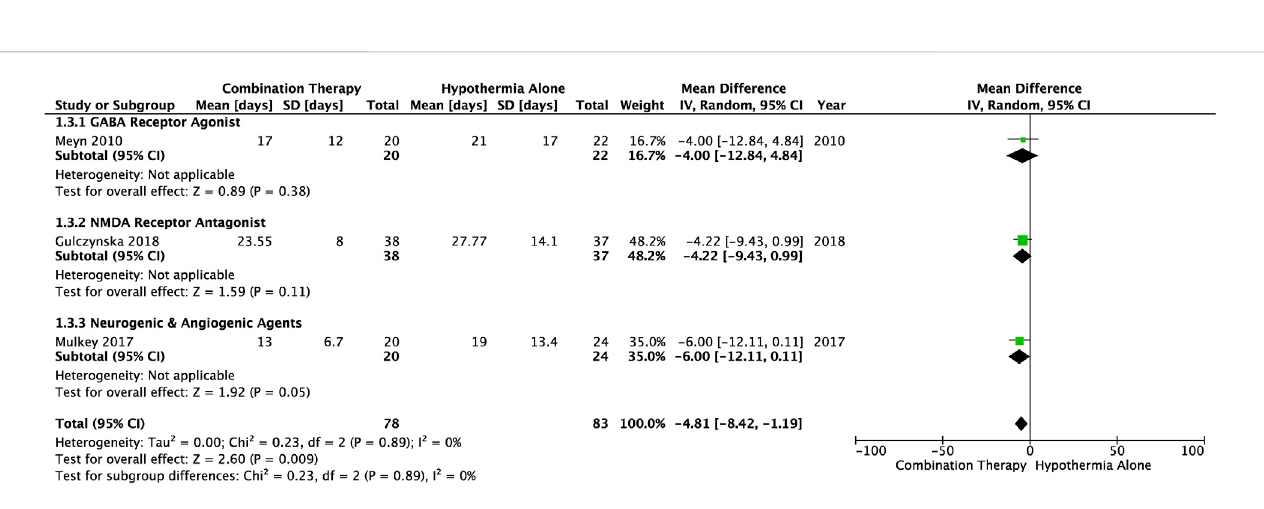
Forest plot of length of hospitalization in HIE infants treated with combination therapy compared to TH alone. Duration reported as mean (standard deviation). Combination therapy-treated infants spent signi fi cant less days in the hospital post-birth compared to infants receiving hypothermia alone: MD − 4.81, 95% CI [ − 8.42. to − 1.19], p =